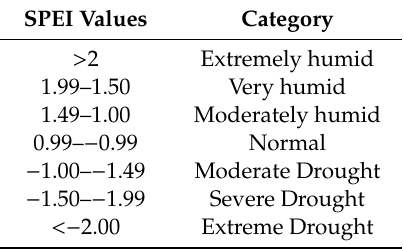
Table 2. Classification of standardized precipitation and evapotranspiration index (SPEI) index.